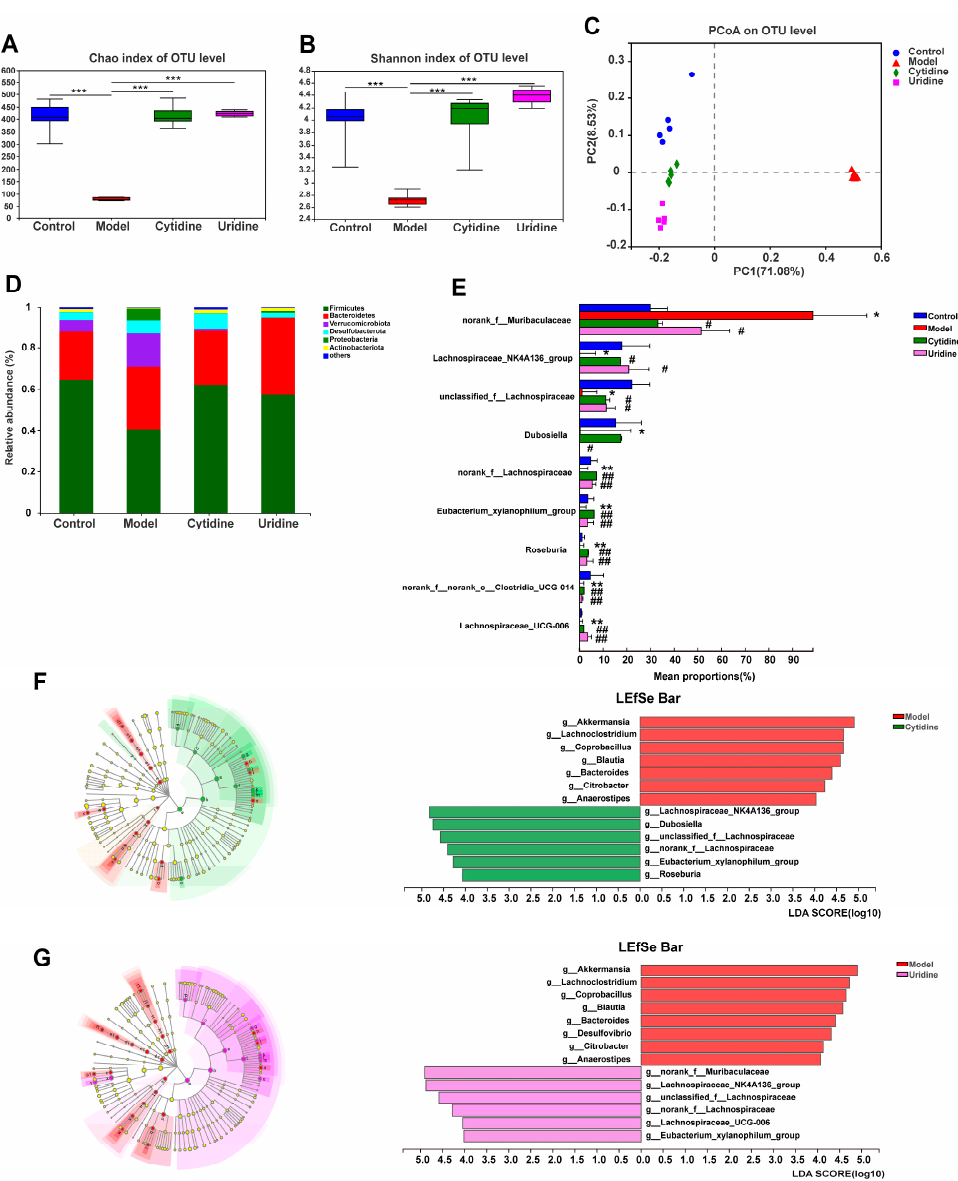
Figure 3. Effect of cytidine and uridine on the structure of gut microbiota in ob/ob mice: ( A ) Chao index, ( B ) Shannon diversity index, ( C ) principal coordinate analysis (PCoA) score plot, ( D ) gut microbiota composition at the phylum level, ( E ) differential abundance of gut microbiota taxa at the genus level, ( F ) linear discriminant analysis (LDA) scores of differentially abundant gut microbiota taxa between the cytidine group and model group using LEfSe method (LDA > 4 and p < 0.05) and ( G ) LDA scores of differentially abundant gut microbiota taxa between the uridine group and model group (LDA > 4 and p < 0.05). Data are expressed as the mean ± SD (n = 5). * p < 0.05, ** p < 0.01, *** p < 0.001 compared with the control group; # p < 0.05, ## p < 0.01 compared with model group.